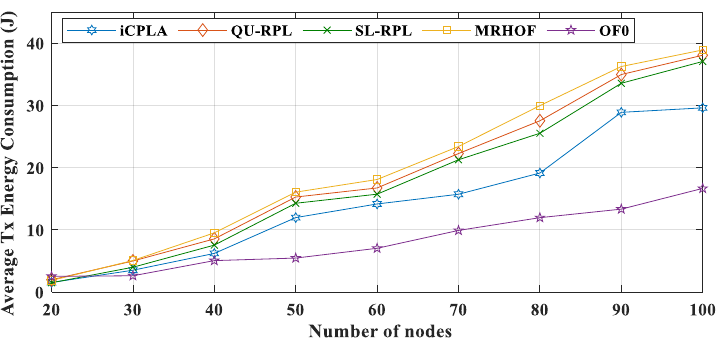
19 of 25 Figure 12. Comparison of LMP energy consumption (J) between i CPLA, QU-RPL, SL-RPL, MRHOF, and OF0 with 𝛼 = 0.3 and 𝛽 = 0.7 in a network of 20 to 100 nodes. Figure 13. Comparison of CPU energy consumption (J) between i CPLA, QU-RPL, SL-RPL, MRHOF, and OF0 with 𝛼 = 0.3 and 𝛽 = 0.7 in a network of 20 to 100 nodes. The energy consumptions during Tx are displayed in Figure 14. The OF0 had the highest total amount of overhead, but it shows a lower Tx value due to the fact of its poor packet delivery ratio. The size of the data packets was more significant than that of the control overhead; thus, it required more energy for transmission. Because most of the packets were dropped in the OF0, the nodes